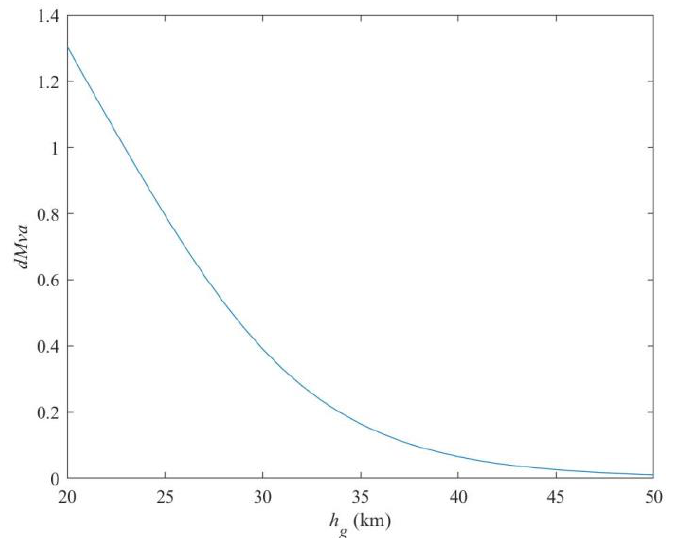
Figure 9. Difference of the equivalent apparent magnitude with the tangent height.